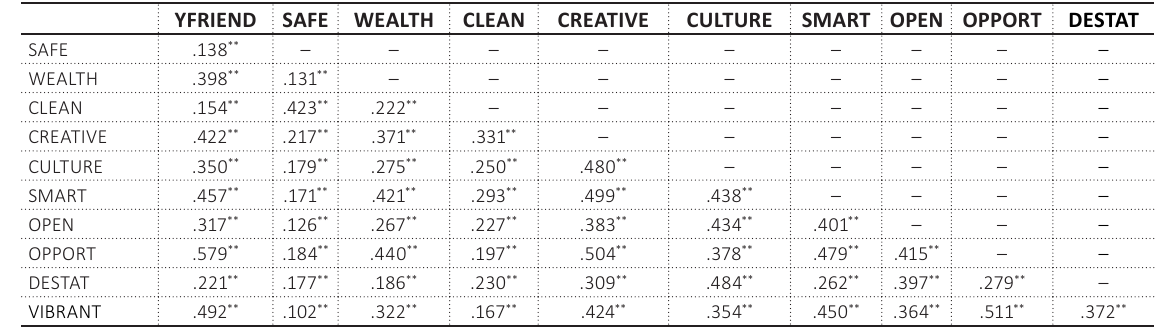
Table 2. Correlation matrix of the regional perception